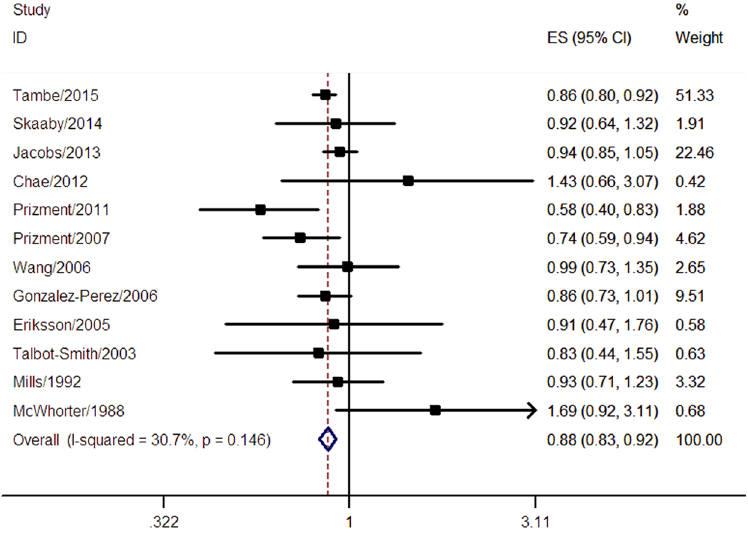
Figure 2. Meta-analysis of the association between allergic conditions and risk of CRC. A fixed-effect model was used in the analysis and a significant inverse association between allergic conditions and risk of CRC was observed.